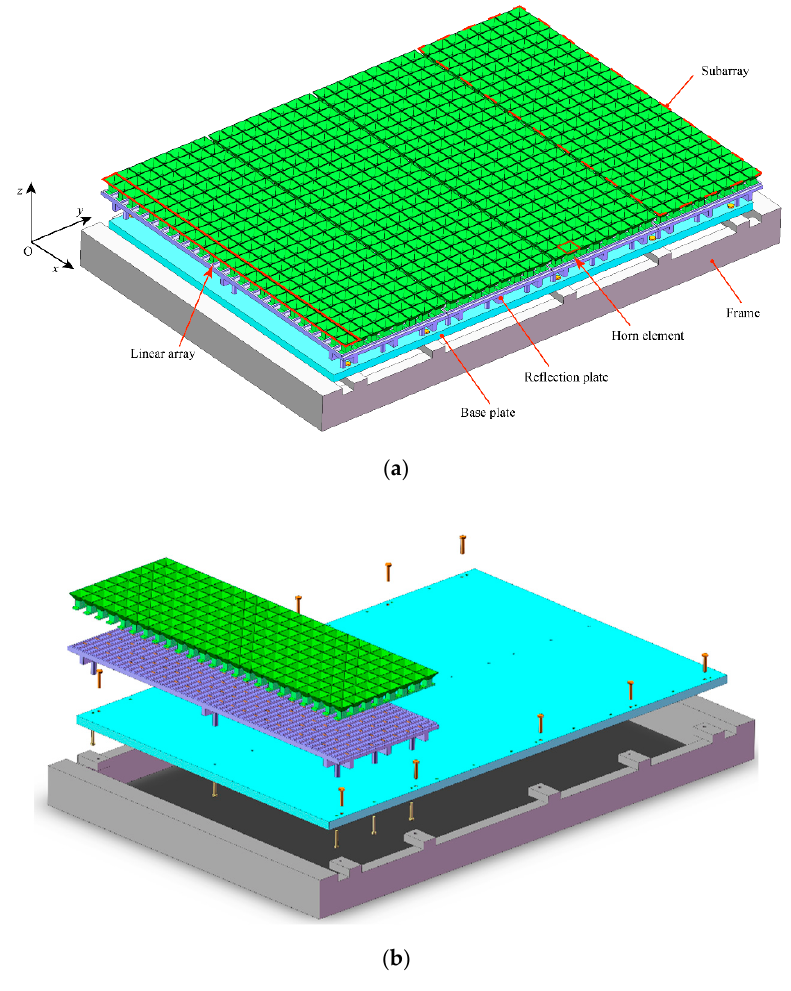
Figure 1. ( a ) The CAD (computer aided design) model of the spaceborne phased array antenna. ( b ) The explosive view of the first subarray in the whole antenna.